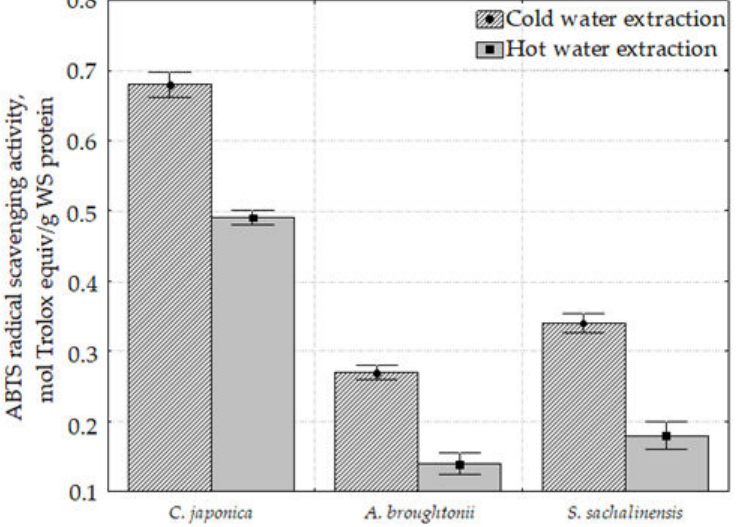
Figure 2. ABTS radical scavenging activity of water-soluble proteins of bivalve